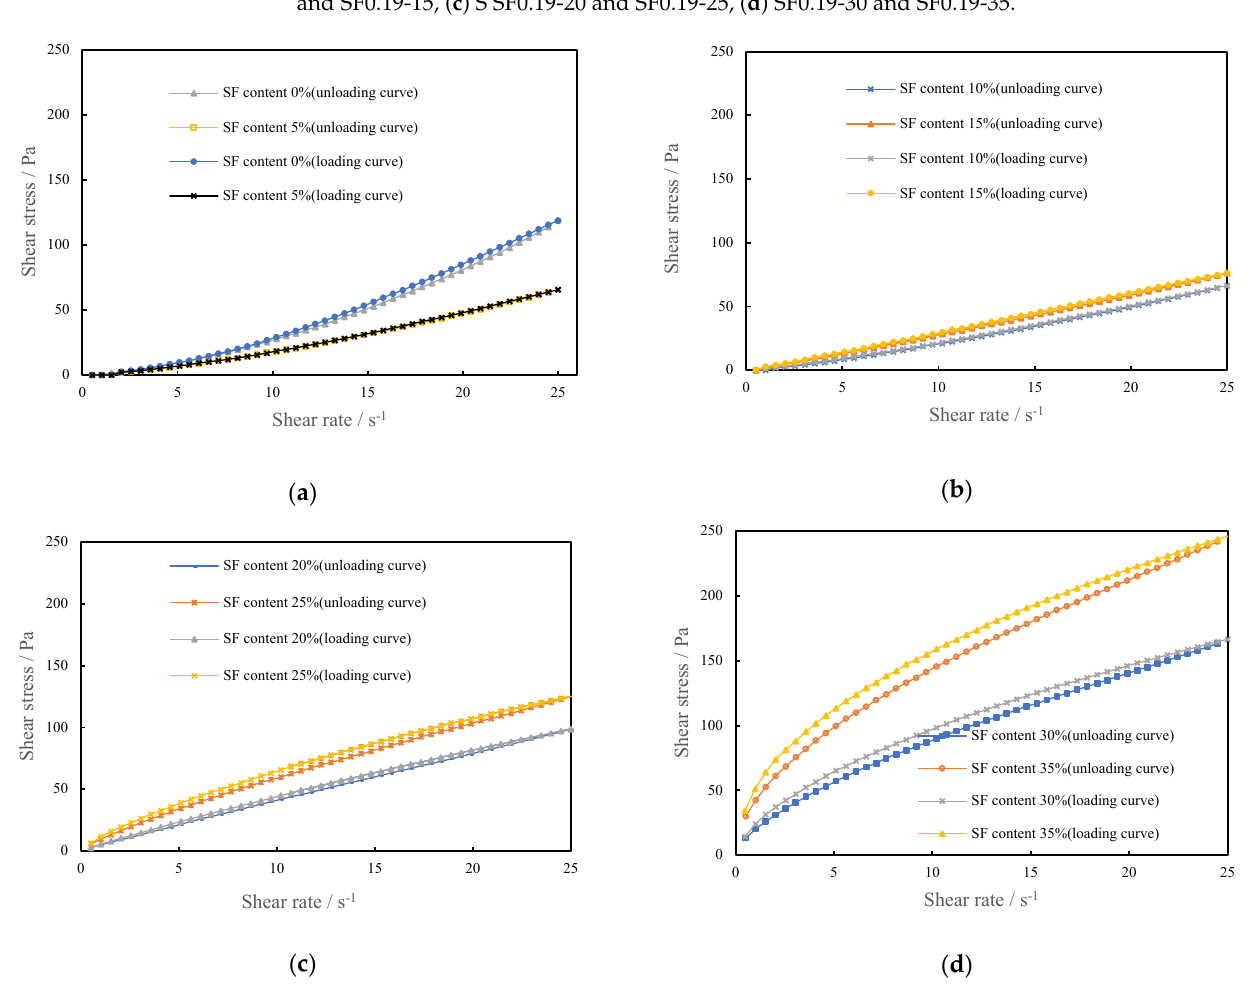
Figure 5. The rheological curve of CSHWMs (W/B = 0.23), ( a ) SF0.23-0% and SF0.23-5, ( b ) SF0.23-10% and SF0.23-15, ( c ) S SF0.23-20 and SF0.23-25, ( d ) SF0.23-30 and SF0.23-35. As observed in Figures 4 and 5, the CSHWM exhibited significantly different rheo- logical properties for different silica fume contents. However, the effect of the W/B ratio